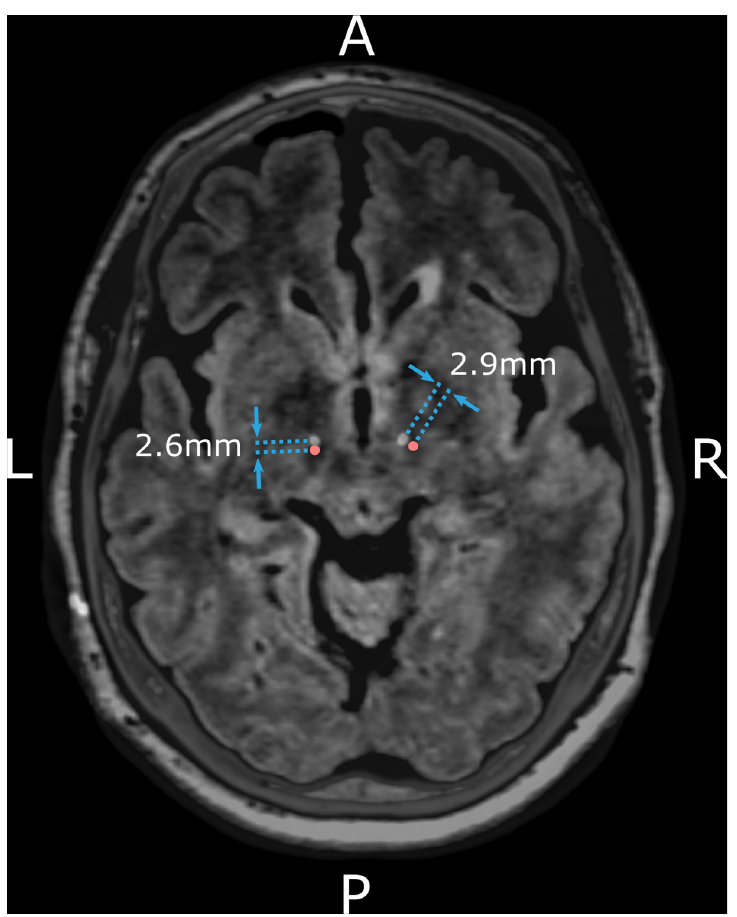
Fig 1. Assessing the error between the actual versus ideal STN-DBS electrode location. An example of the fused preoperative MRI and postoperative CT for a single patient with two electrodes implanted in the STN region. The nominated, ideal location to apply DBS in the dorsal STN is marked in red. The location of the electrode trajectory at this axial slice is defined by the electrode artefact occurring on CT (hyperintense voxels). The electrode location error is the straight-line (Euclidean) distance between the actual electrode trajectory versus the nominated, ideal location to apply DBS, as indicated by the blue arrows and measured in millimeters. A = Anterior, P = Posterior, L = Left, R =